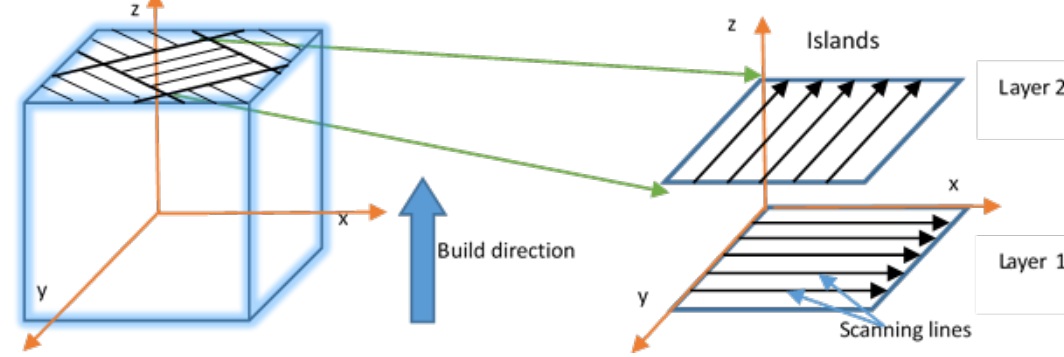
Figure 1. “Island” scanning strategy, shaped like checkerboards employed in the SLM process of 316L SS samples.